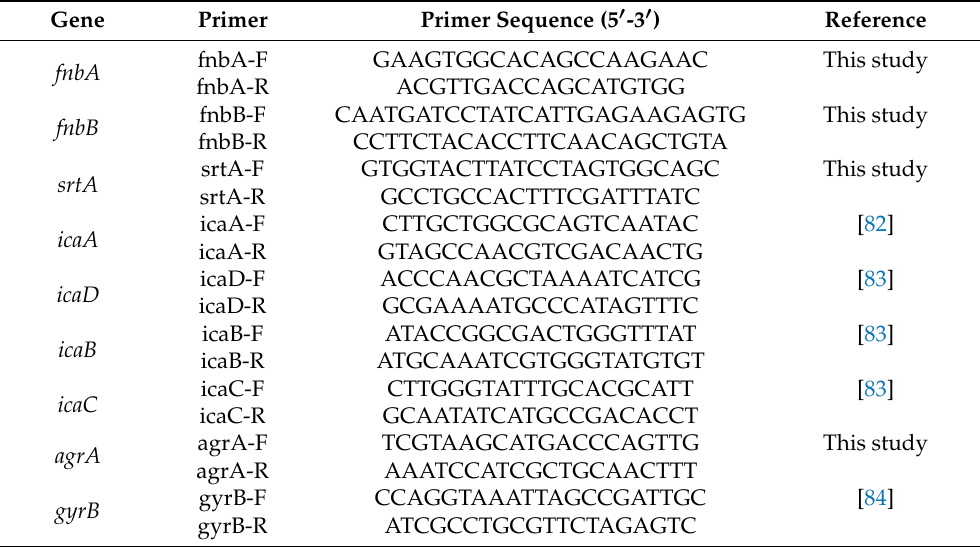
Table 4. Primers used in the study of gene expression in S. aureus CCM4223. Gene Primer Primer Sequence (5 (cid:48) -3 (cid:48)